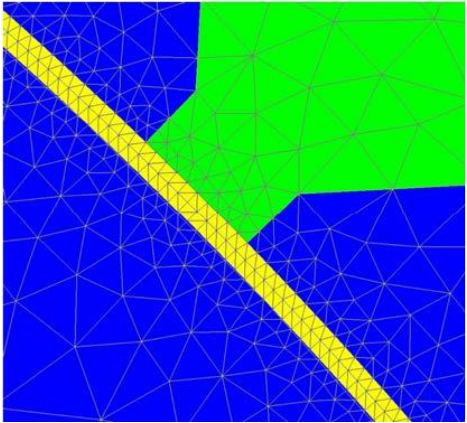
Figure 3. Mesh in the air gap and in regions close to it.